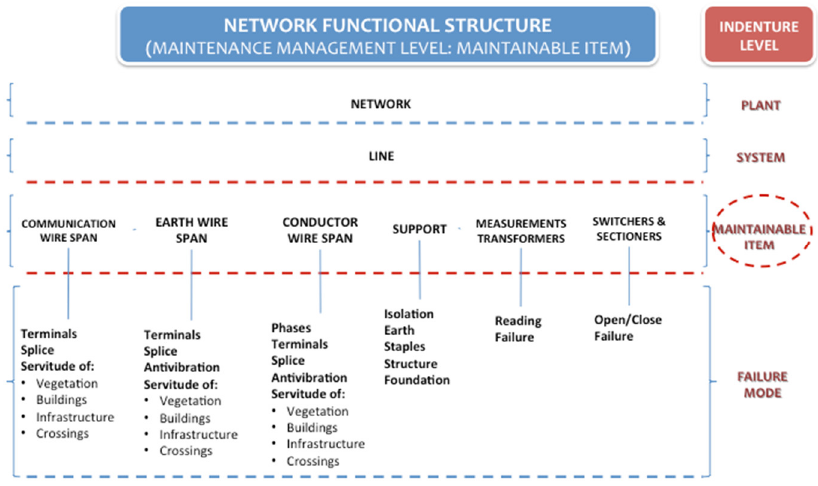
Figure 12. Selected functional structure of the network for the analysis.